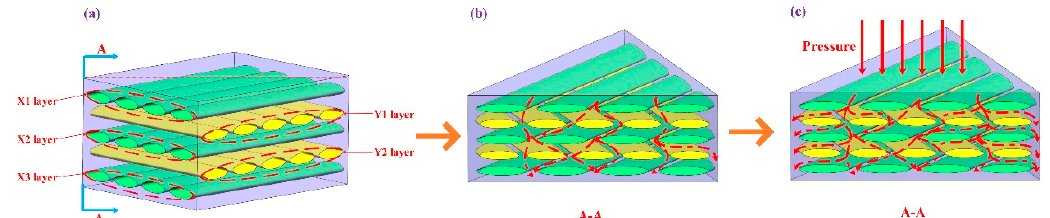
Figure 10. Carbon fiber distribution model and infiltration mechanism: ( a ) carbon fiber structure distribution model; ( b ) initial infiltration of material in no pressure; ( c ) full infiltration of material in pressure.